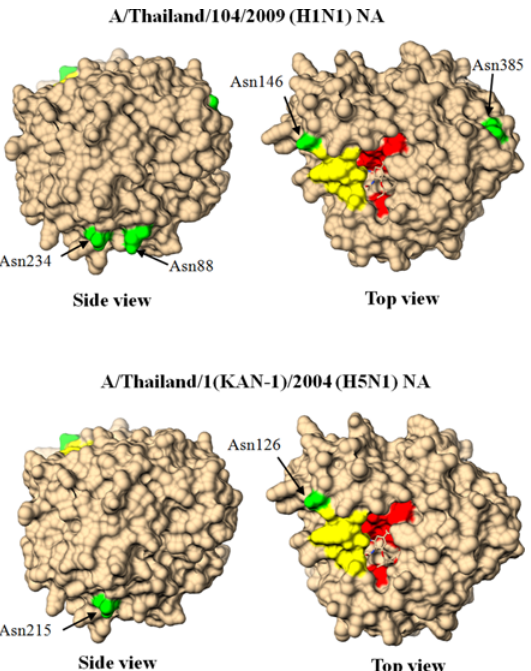
Fig 4. Potential N -linked glycosylation sites on NA globular domain. The glycosylation sites on the molecular surfaces of NA globular head domain monomer as demonstrated by three-dimensional structures based on A/Vietnam/1203/04 (H5N1) (PDB codes: 2HU0). Potential N -linked glycosylation sites are highlighted in green, structure of the 150-loop is highlighted in yellow and amino acids related to the NA active sites are highlighted in